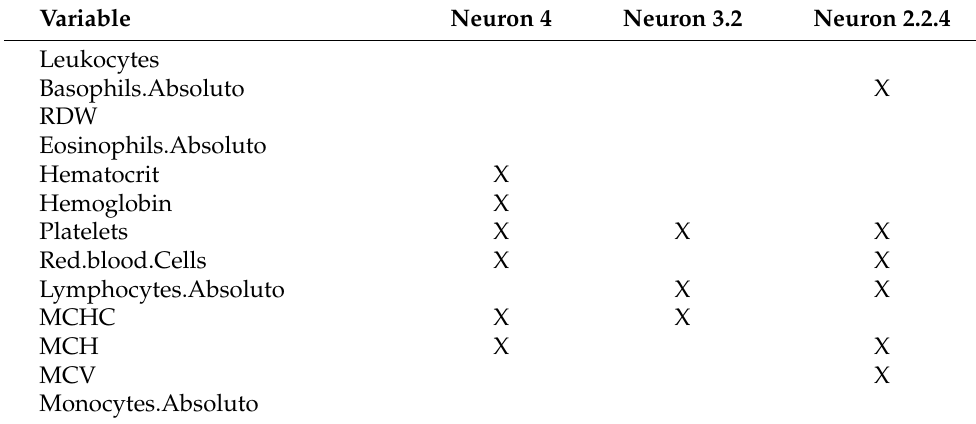
Table 14. Summary of the variables found in the neuron analysis— TESSOM . Variable